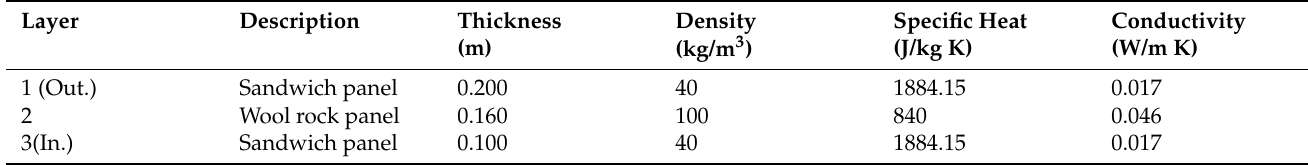
Table 2. Thermophysical characteristics of east and west walls and roof.